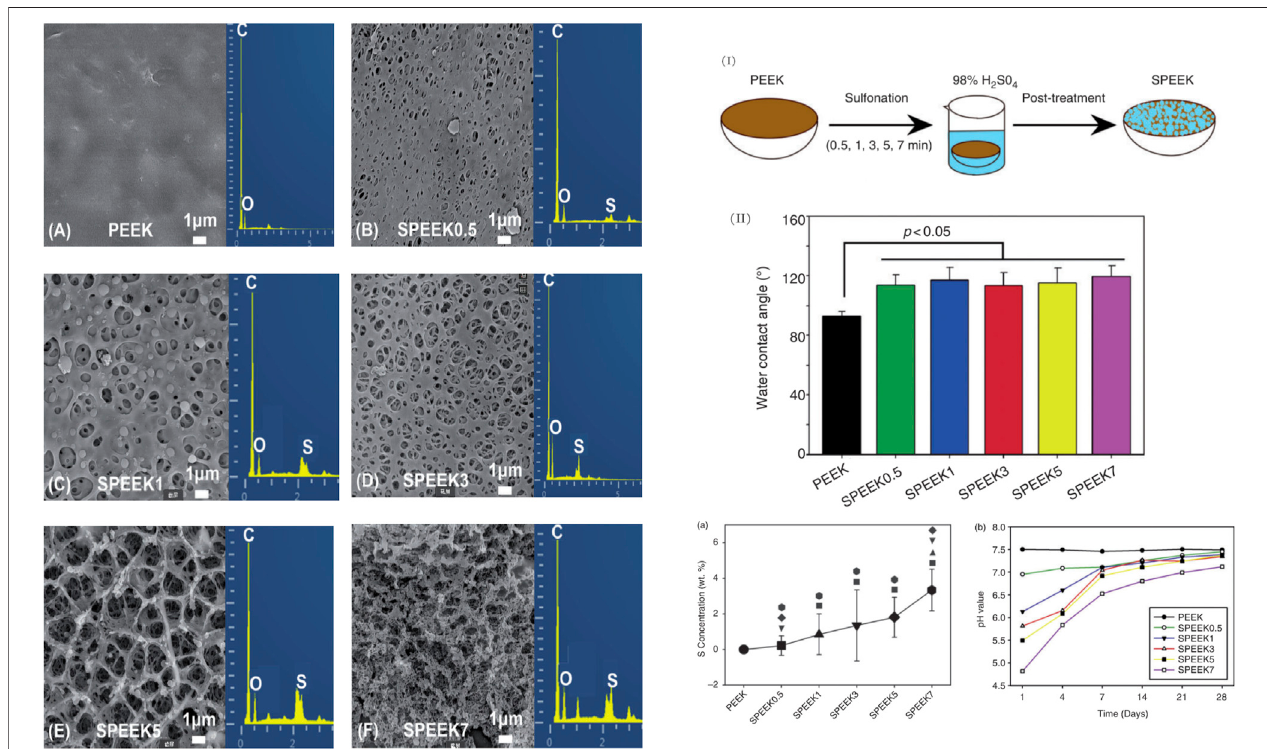
FIGURE 4 | Sulfonation of PEEK. (I) Sulfonation times: 0.5 min (SPEEK0.5), 1 min (SPEEK1), 3 min (SPEEK3), 5 min (SPEEK5), and 7 min (SPEEK7); untreated PEEK as the control. (II) Quantitative comparison of water contact angles. (a) S concentration of each group measured by EDS (the marks represent p < 0.05); (b) pH values at 1, 4, 7, 14, 21, and 28 days. (A – F) Morphology of the SPEEK surface characterized by SEM (left row) and chemical composition characterized by EDS (right row). Reproduced from Ma R. et al (2020). Copyright (2020), with permission from SAGE